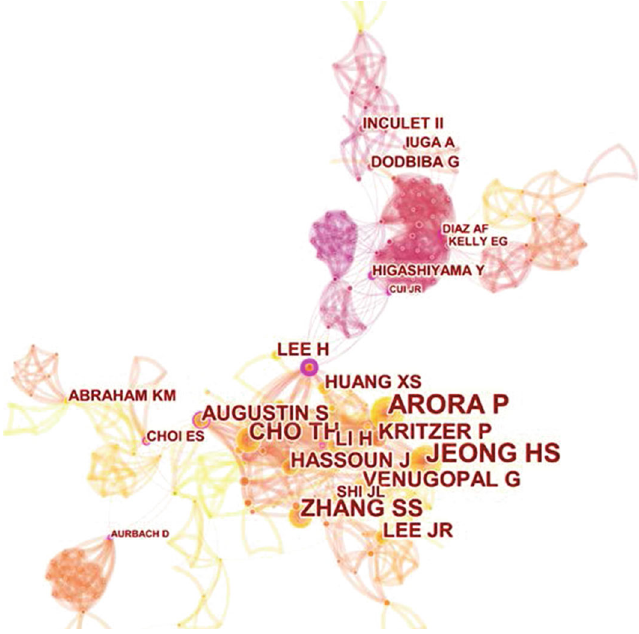
Figure 5: Author cocitation network